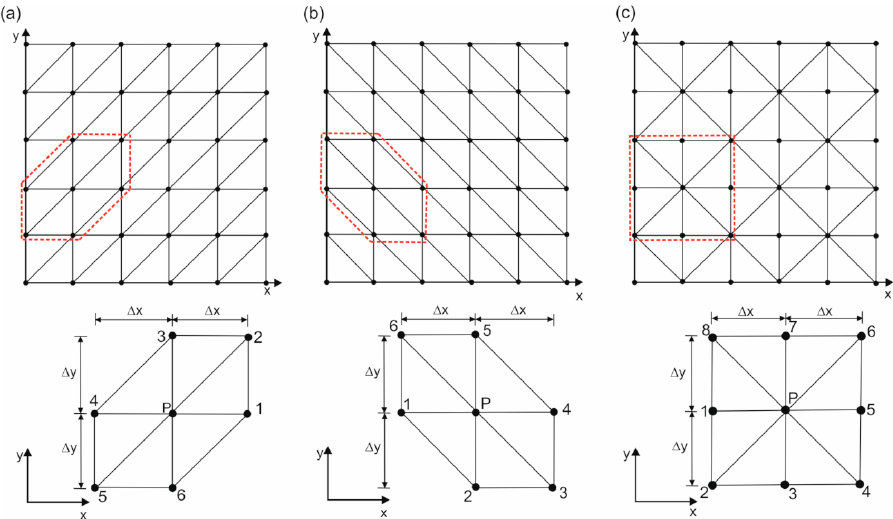
Figure 2. Mesh structures of triangular elements: ( a ) six-node structure (6N); ( b ) six-node structure, with an inverse orientation (6NI); ( c ) eight-node structure